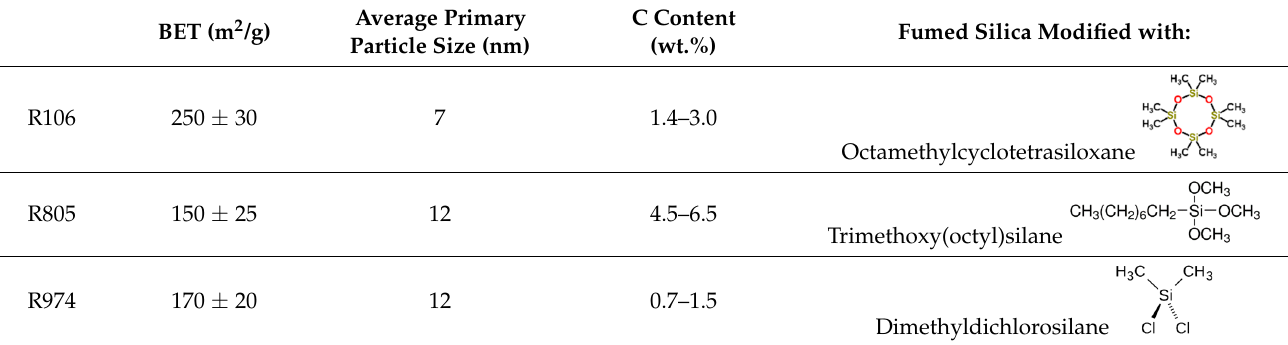
Table 2. Physicochemical characteristics of the HFS.